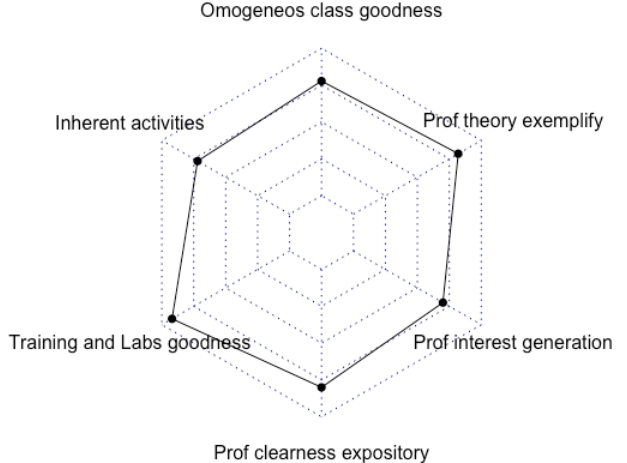
Fig. 9. Radar plot with the results of the Linear Algebra and Geometry course's survey